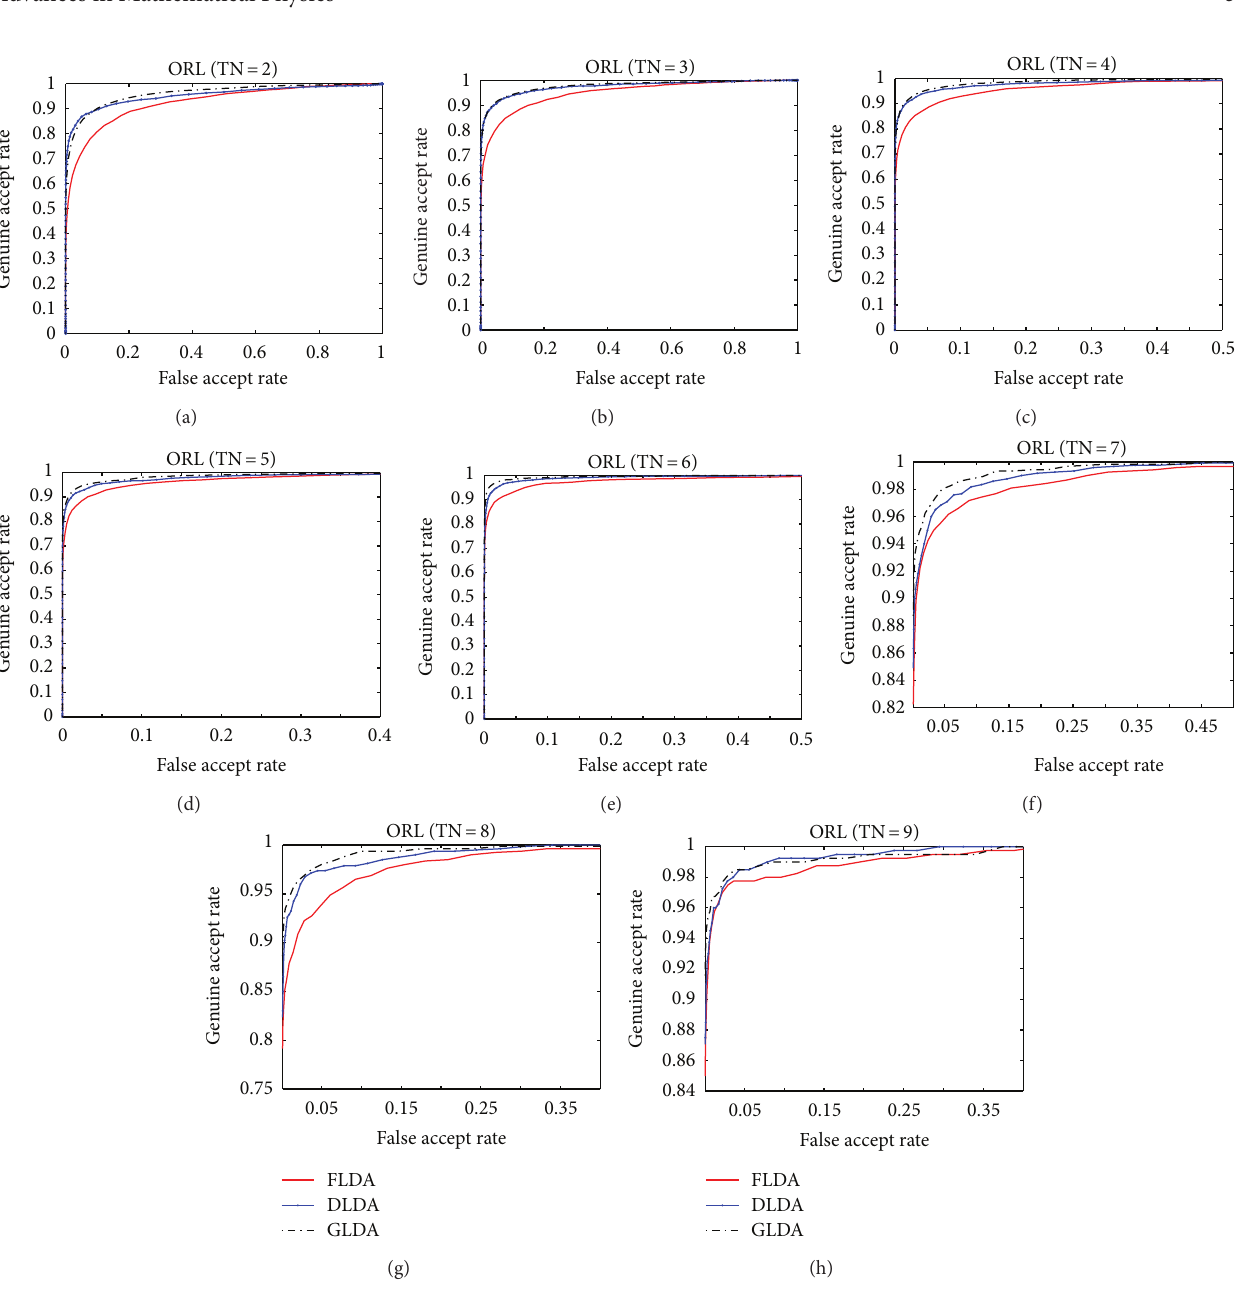
Figure 5: ROC curve comparisons on the ORL